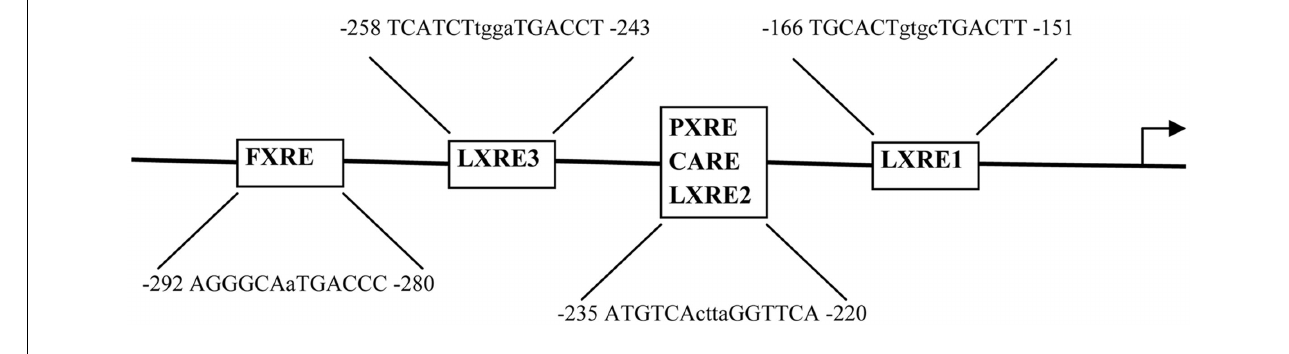
There are three LXR binding sites (LXRE1-3) in the Akr1b7 promoter. In response to specific ligand treatments, the PXR/RXR, CAR/RXR, and LXR/RXR heterodimers bind to the same binding site (LXRE2) in the Akr1b7 promoter.